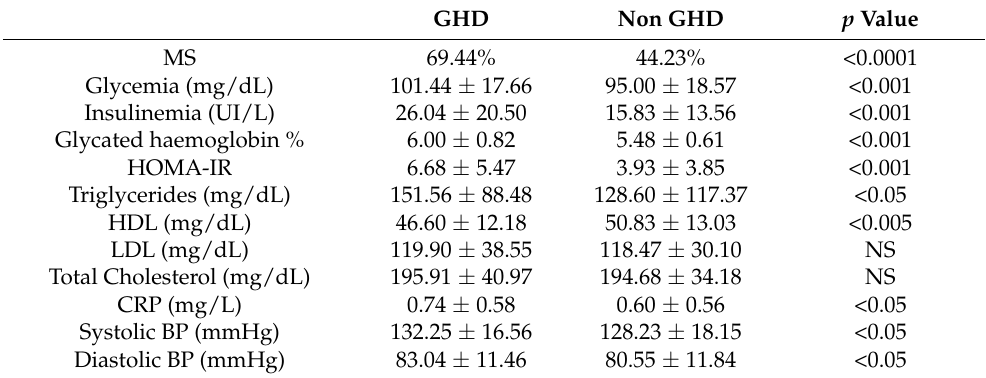
Table 3. Comparison of metabolic parameters between the GHD population and the control group.